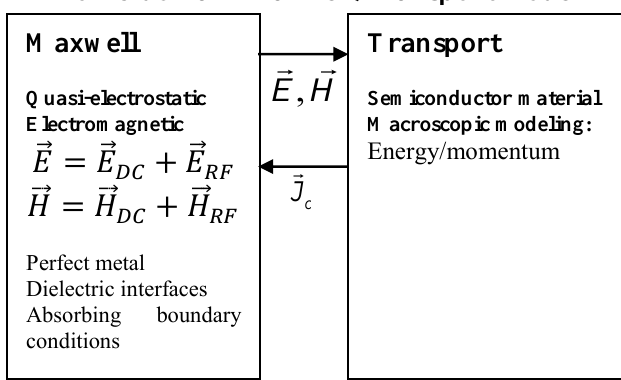
Figure 1: Simax_2D simulator main organization The electromagnetic model is applied on a physical rectangular area in the x and y directions. It is split in quasi- electrostatic and electrodynamic sub-entities (figure